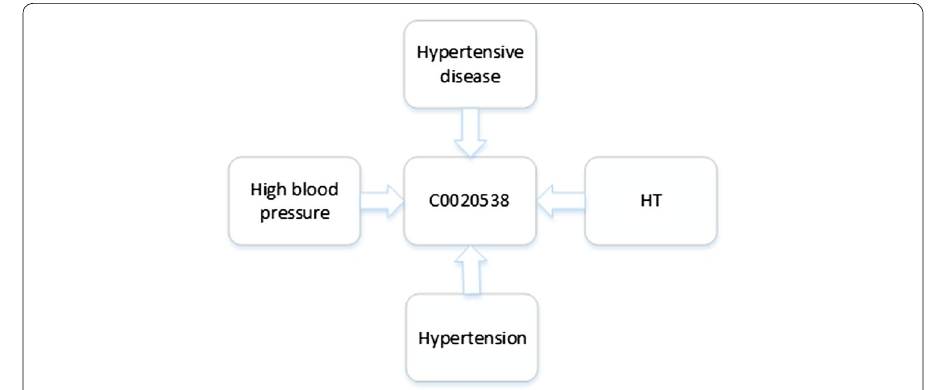
Fig. 2 Normalization of hypertension and its variants to a single UMLS CID